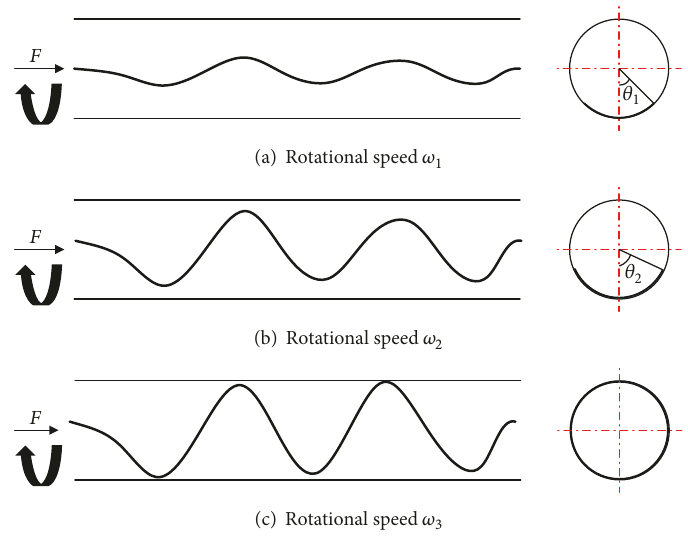
Figure 2: Schematic diagrams of dynamic physical